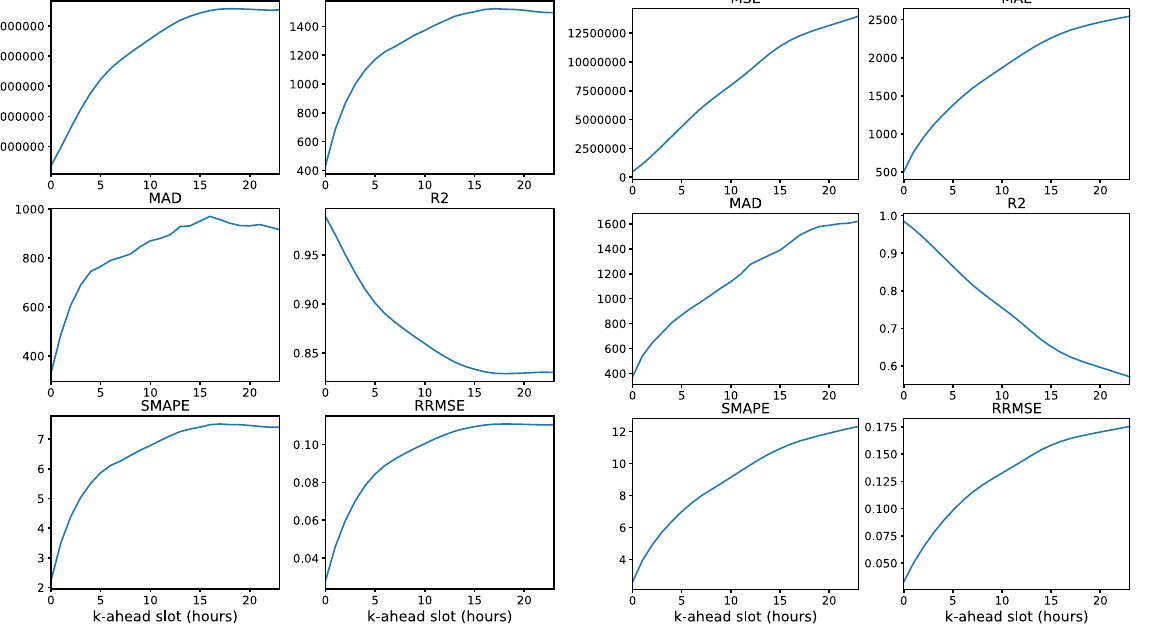
Figure 10. Forecast metrics for successive predicted time-slots for models: classic ML, (linear regression) ( 𝑓 = 1, 𝑝 = 168, 𝑘 = 24) ( left ) and Seq2seq + attention (2 LSTM + 1 FC) ( 𝑓 = 45, 𝑝 = 24, 𝑘 = 24) ( right ).